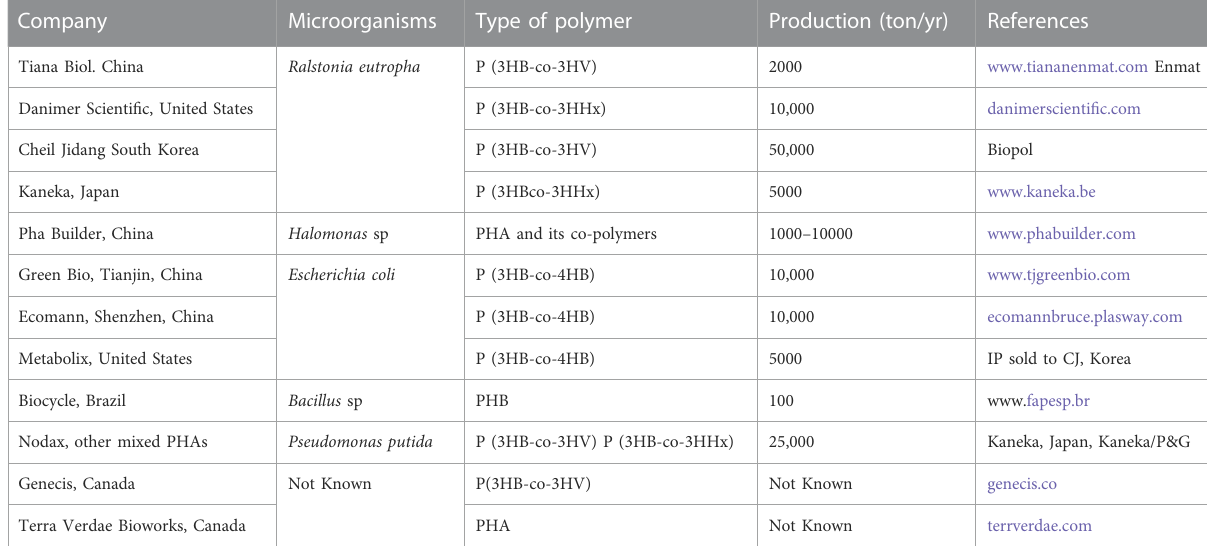
TABLE 3 Industrial companies for PHA